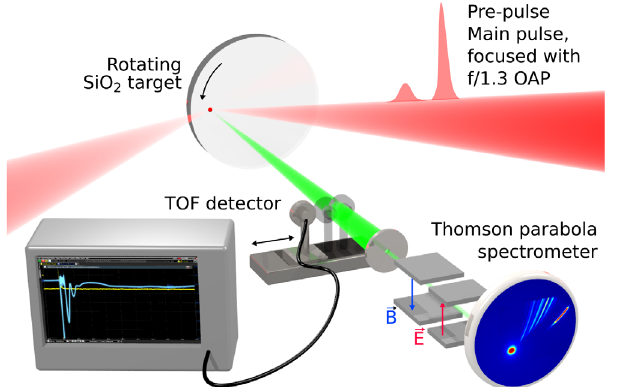
FIG. 1. Experimental